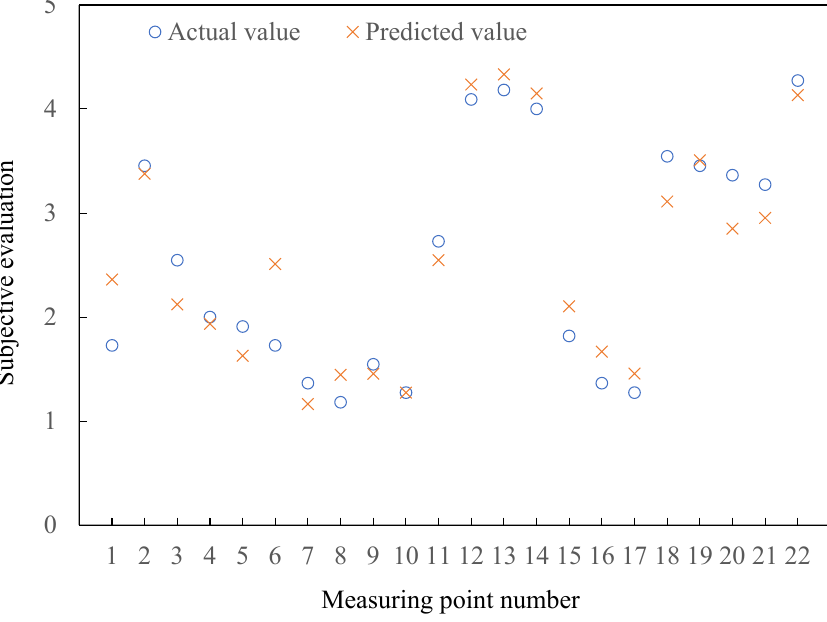
Figure 18. Evaluation performance of the shallow neural network model.